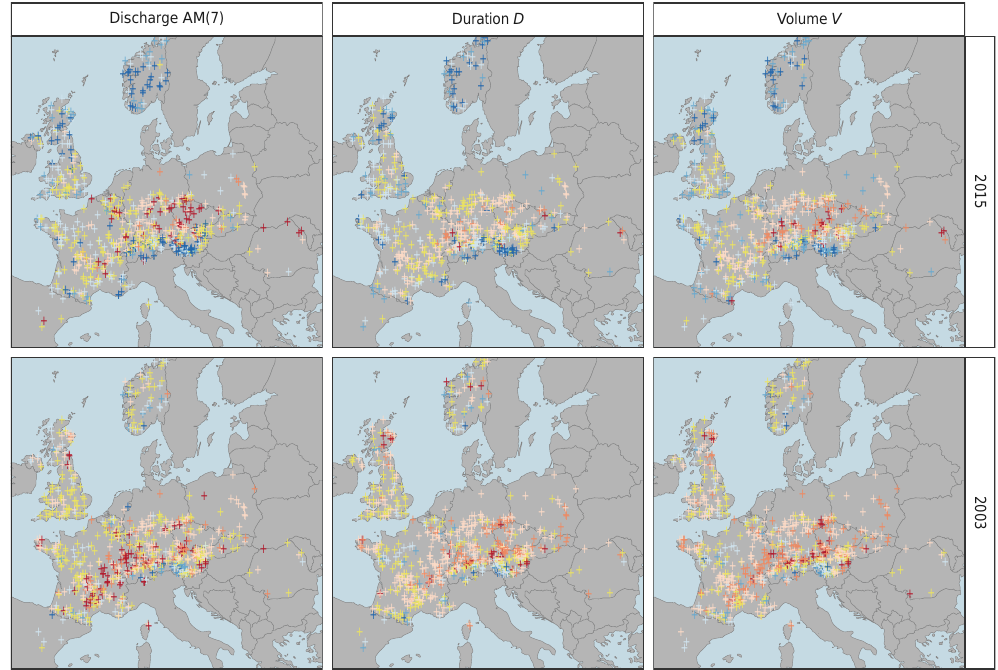
Figure 1. Return periods T (in years) of annual low flow discharge AM(7) (left panels), duration D (center panels), and deficit volume V (right panels) for the drought events of 2015 and 2003. Low flows and drought conditions below average conditions (return period > 2 years) are indicated by yellow to red colors. Severe events (return periods (20, 50] and > 50 years) are indicated by orange and dark red